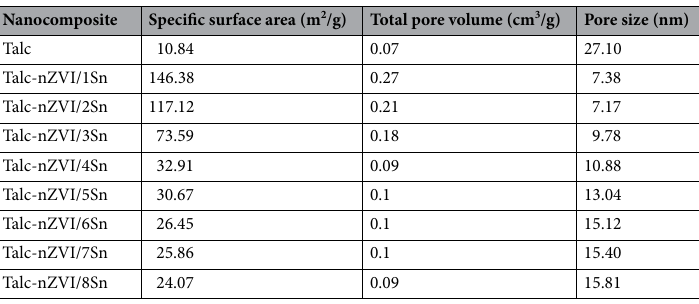
Table 1. BET characteristics of different talc-supported nZVI/Sn bimetallic particles.